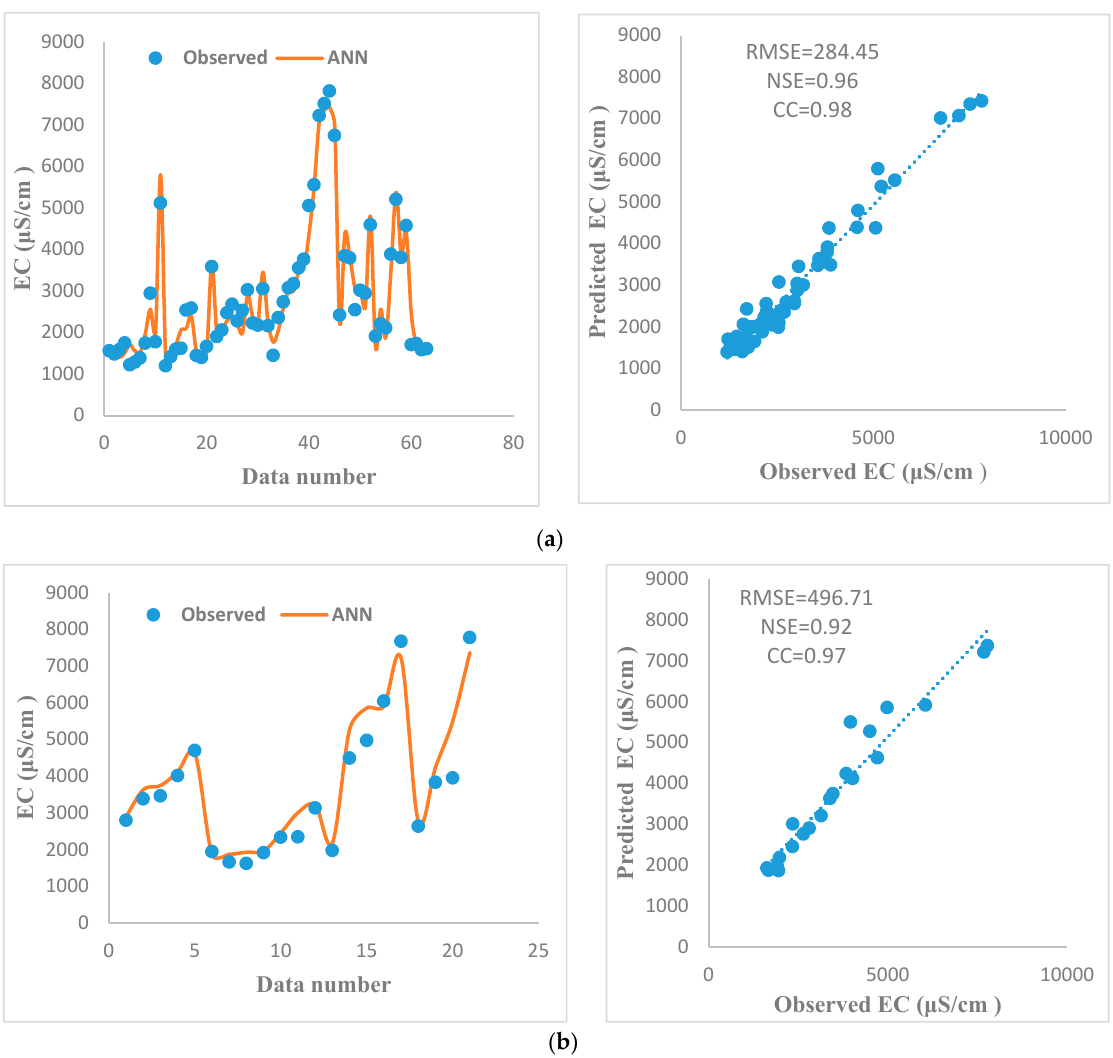
Figure 8. Comparative plots of observed and predicted EC values using ANN model for ( a ) calibration data set and ( b ) validation.